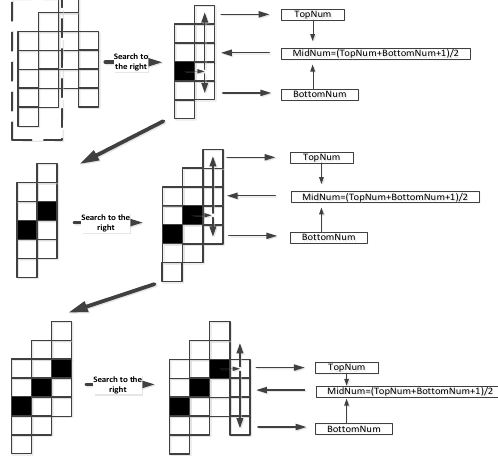
Figure 3. The process of thinning algorithm